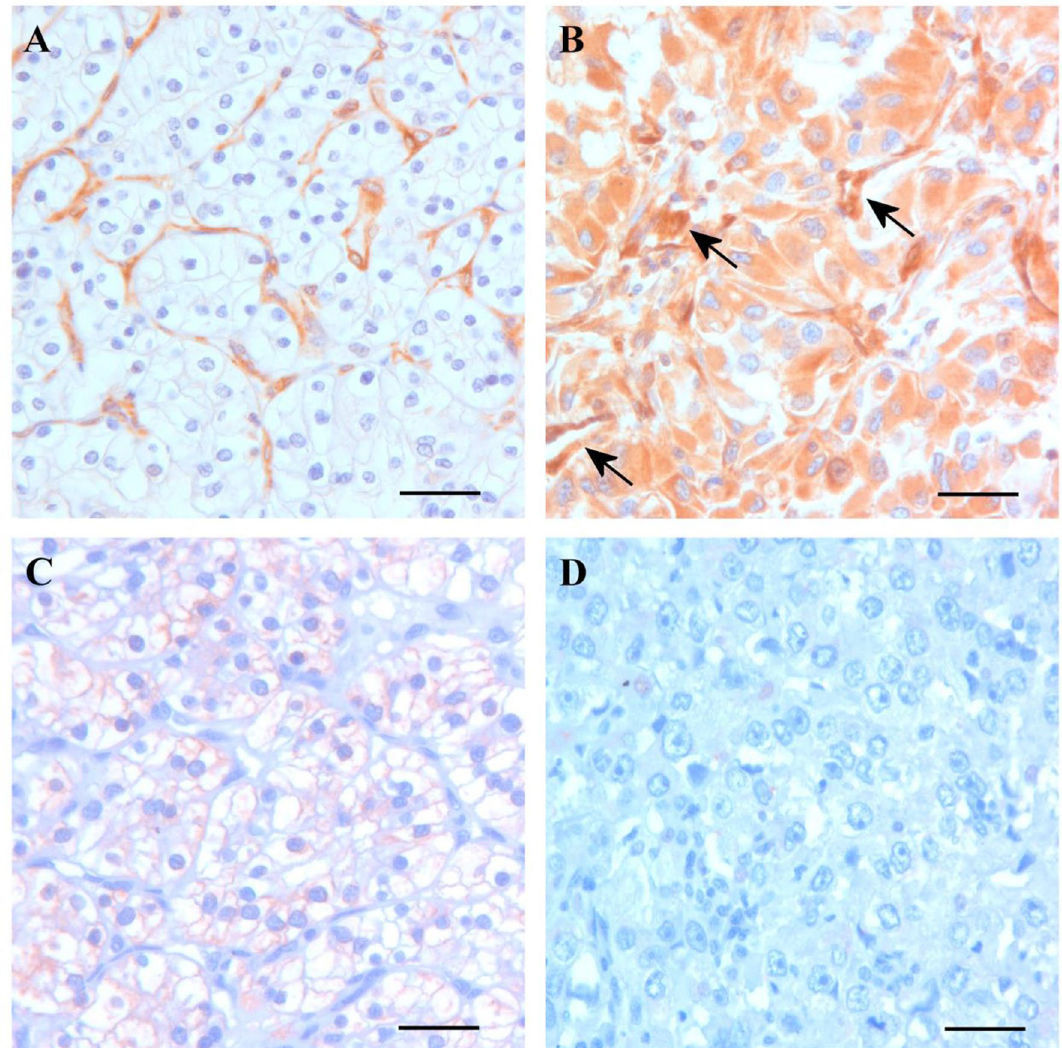
Figure 1. Expression of TXNIP and IL1β in the two groups of conventional RCC. ( A ) No cytoplasmic TXNIP expression was detected in the first group of tumours of excellent prognosis. Endothel cells of the fine vascular network display TXNIP positivity. ( B ) Tumour of the second group with poor prognosis display strong cytoplasmic TXNIP expression and contains few tourtous vessels (arrows). ( C ) Grade 1 tumour of the first group displaying cytoplasmic IL1β expression. ( D ) Grade 2 tumour of the second group without IL1β immunostaining. No IL1β expression can be seen in the tumour microenvironment. Scale bar: 40 to low grade tumours 25 . In experimental mouse model the silencing of TXNIP increased the predisposition to hepatocellular carcinoma (HCC) 30 . In two studies expression of TXNIP was detected in all of primary human HCC, but the expression was decreased in 66% and 50% of the cases, respectively 28,32 . Based on these data TXNIP was suggested to be a tumour suppressor gene. However, in line with our results a significantly increased expres- sion of TXNIP and elevated ROS level was associated with invasive growth in human hepatocellular carcinoma and high expression of TXNIP was an independent prognostic factor in non-small lung cancer 22,23 . TXNIP is a member of α-arrestin protein family and by directly binding to the antioxidant TXN blocks its reducing potential 13 . TRXs are small redox active proteins that play an important role to maintain the cellular redox balance under normal conditions. Elevated TXNIP expression and oxidative stress influence several bio- logical functions, regulates cell growth, differentiation and apoptosis 33,34 . By supporting the ROS production TXNIP promotes endothelial cells proliferation and angiogenesis by activating the transcription factor NF-kB and regulating the vascular endothelial growth factor (VEGF), and vascular endothelial growth factor receptor 2 (VEGFR2) signalling 18,35,36 . The importance of TXNIP in the maintenance of endothelial homeostasis was recently demonstrated by a TXNIP-KO mouse experiment 37 . ROS are also involved in the induction of HIF family transcription factors the major signalling components downstream of hypoxia 38 . Many of the HIF target proteins are also involved in the angiogenesis. In our study no HIF1α expression has been observed the tumours cells.